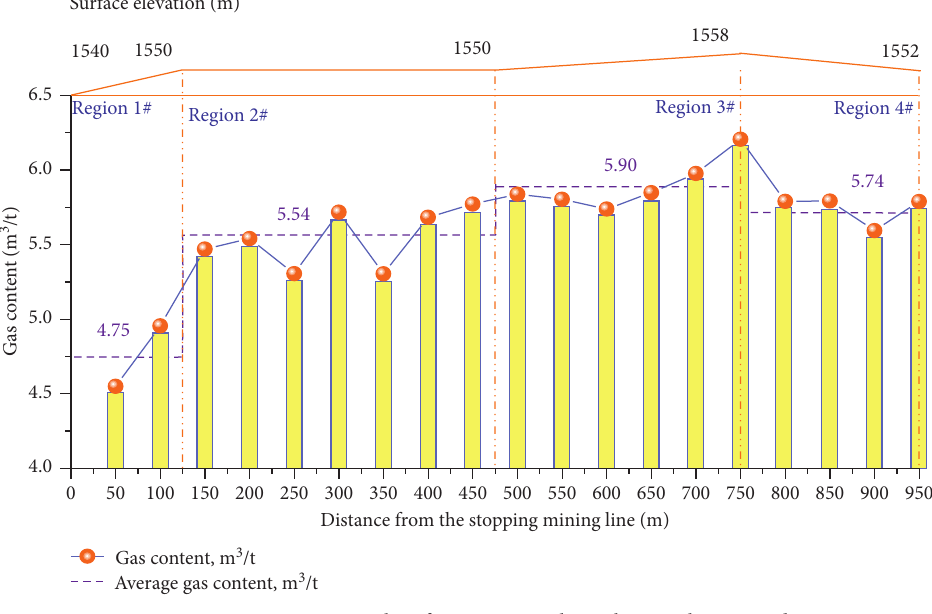
Figure 12: Determination results of gas content along the ventilation